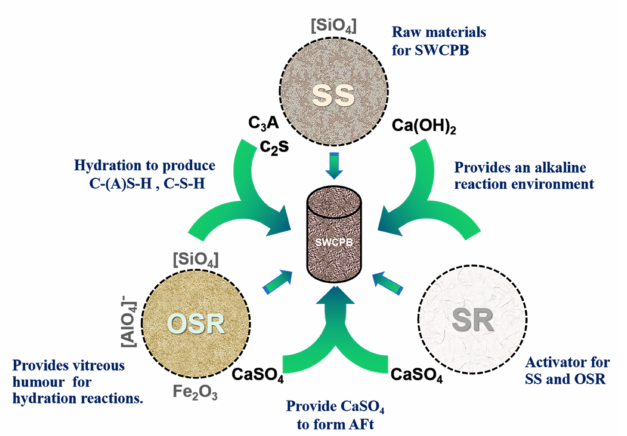
Figure 4. The synergism of the